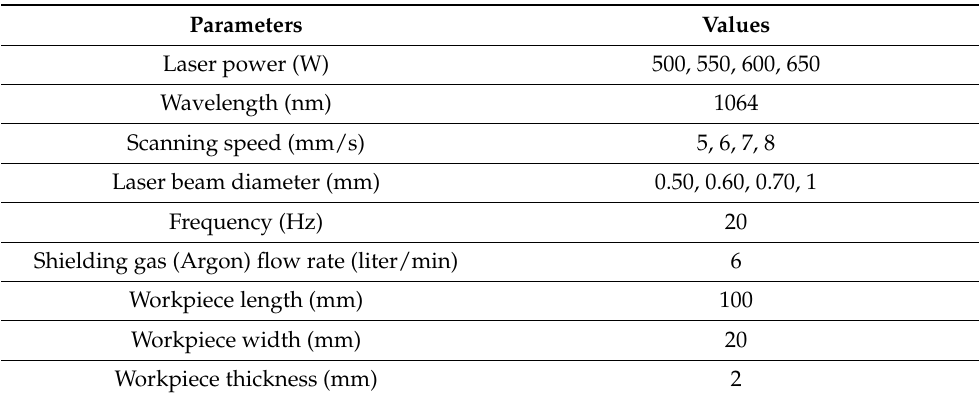
Figure 1. Experimental set-up for laser welding. Table 1. Process parameters of laser welding.